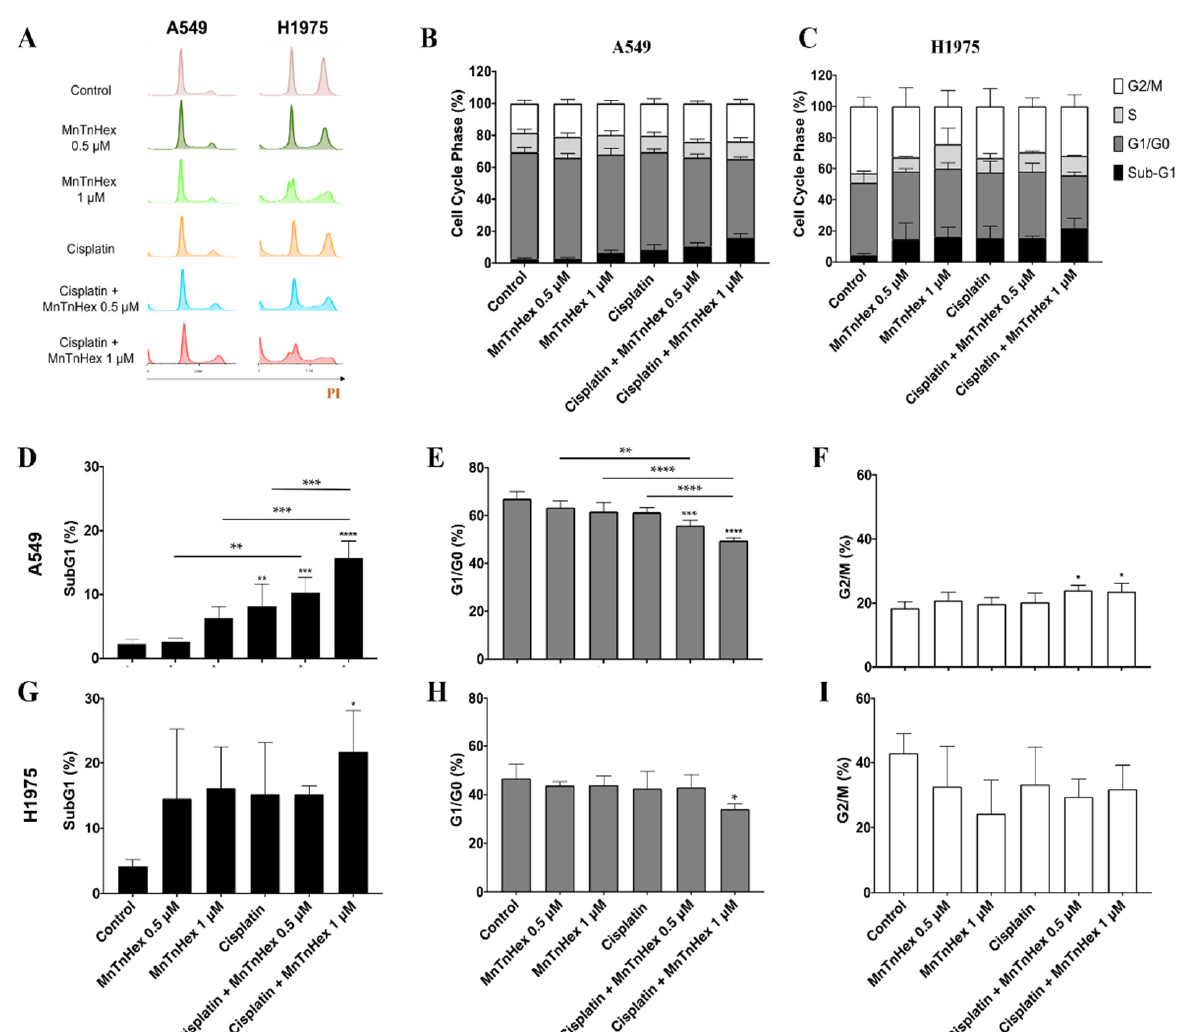
Figure 5. Effect of MnTnHex combined with cisplatin in A549 and H1975 cells on cell cycle distribution. Cells were treated with the indicated concentrations of MnTnHex and cisplatin (1 µ M) for 72 h and DNA content was assessed on fixed cells by flow cytometry. ( A ) Representative flow cytometry histograms of PI-stained cells. Summary data of cell cycle populations for ( B ) A549 and ( C ) H1975 cells. Individual populations for ( D – F ) A549 and ( G – I ) H1975 cells. Values represent mean ± SD ( n = 3–4) and are expressed as percentages of total cells. * p < 0.05, ** p < 0.01, *** p < 0.001 and **** p < 0.0001 (one-way ANOVA with Tukey’s multiple comparisons test) when compared with control cells, or between any two conditions as indicated in the figure by connecting lines.